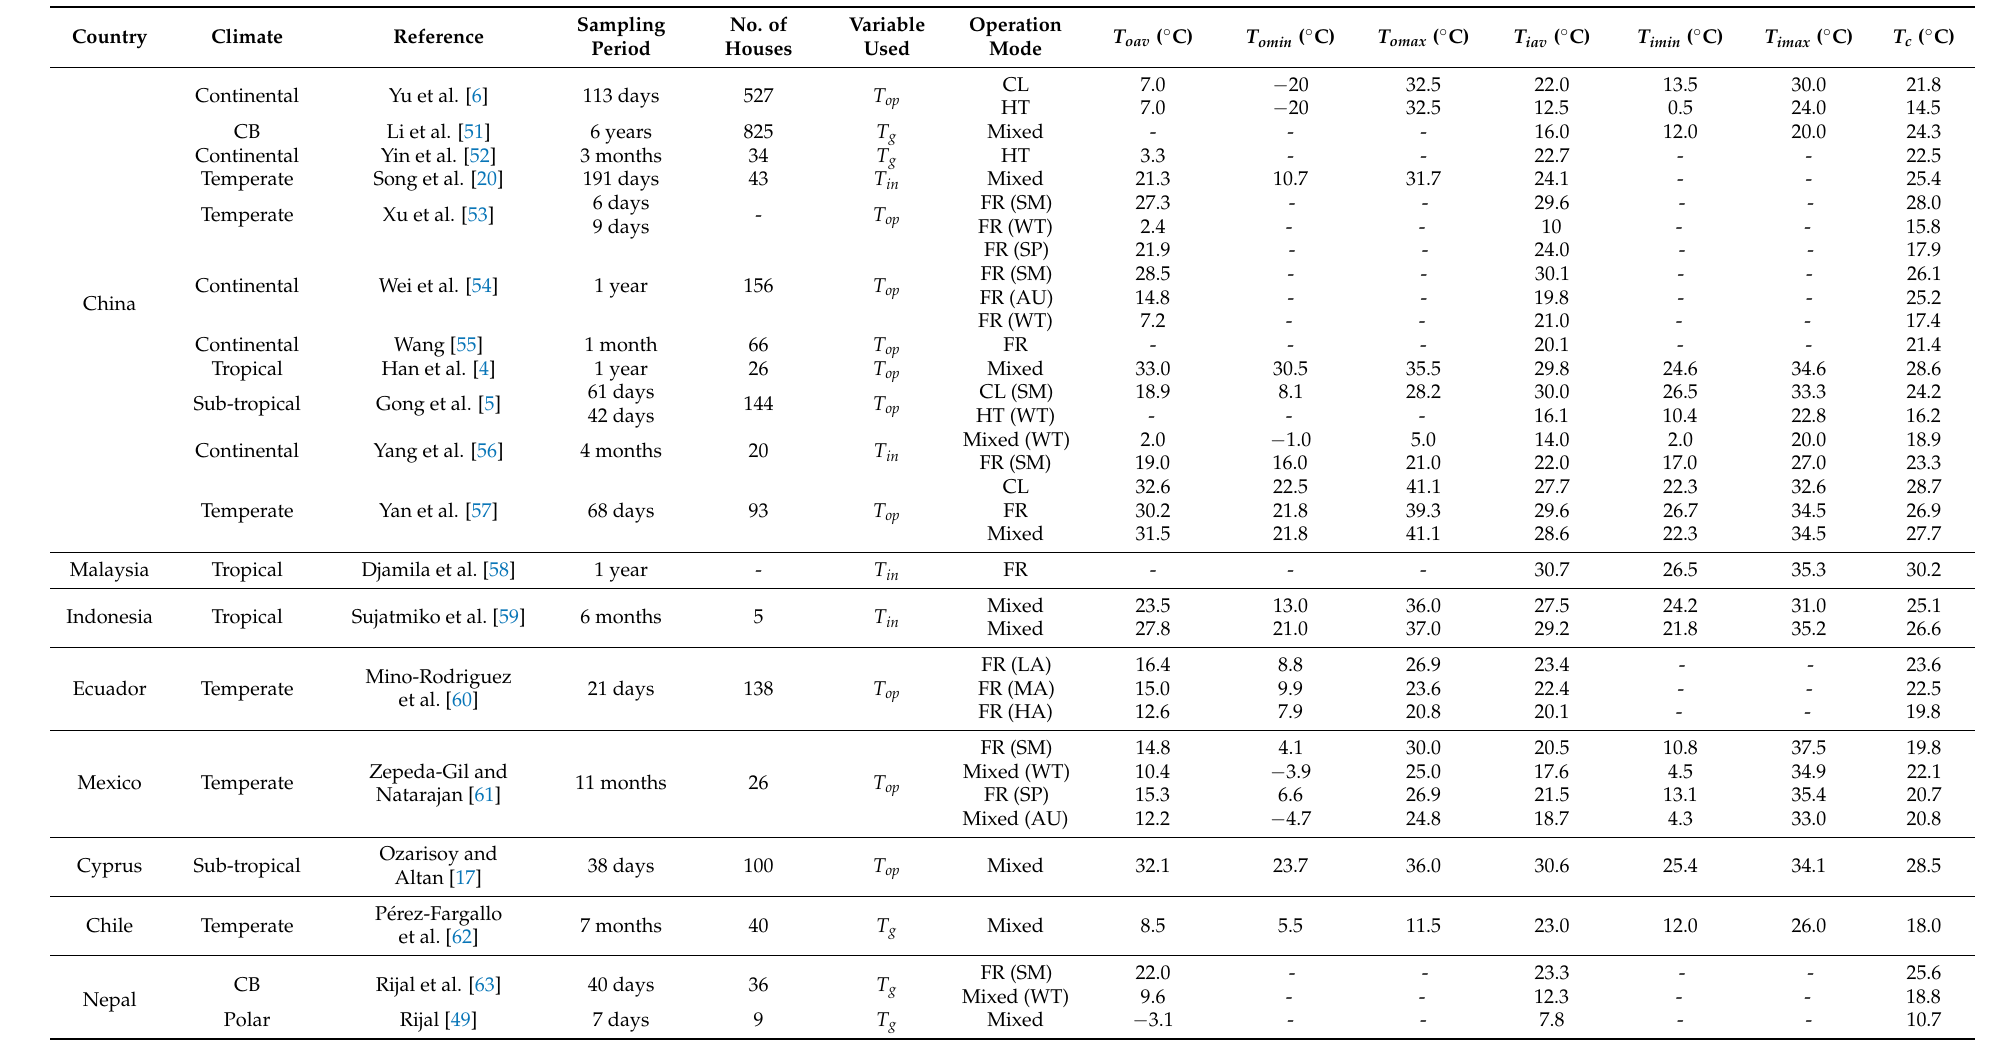
Table 1. Previous thermal comfort field measurement